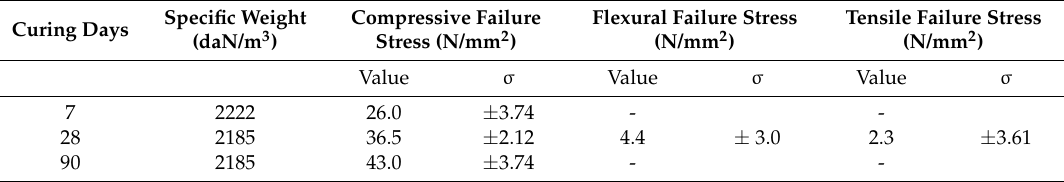
Table 5. Mean values and standard deviations of the mechanical characteristics of slag and fly ashes concrete. Curing